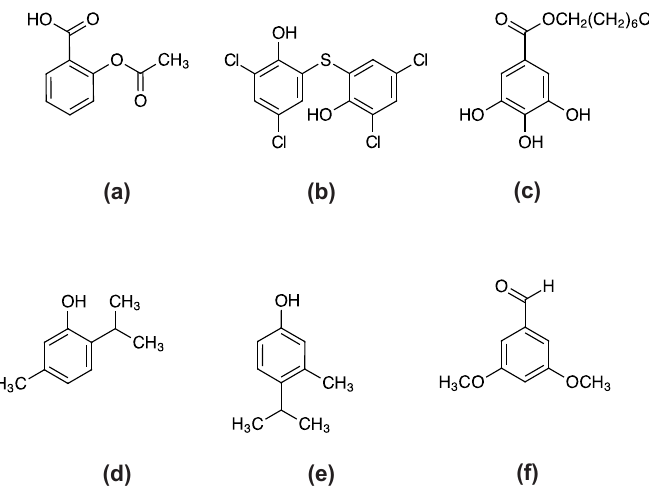
Figure 1. Structures of compounds examined in this study: ( a ) Aspirin; ( b ) bithionol; ( c ) octyl gallate; ( d ) thymol (2-isopropyl-5-methylphenol); ( e ) 4-isopropyl-3-methylphenol; ( f )